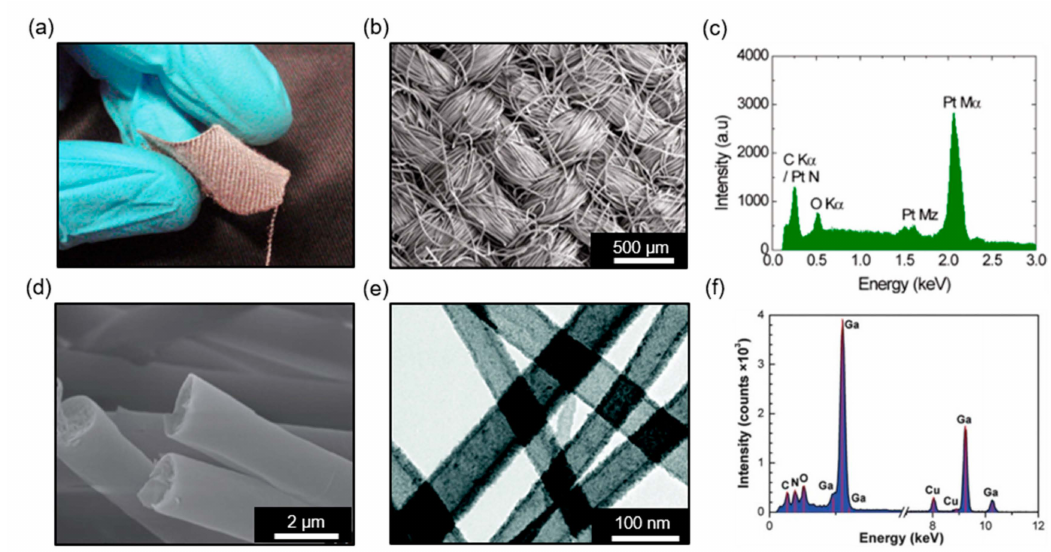
Figure 5. Various inorganic thin films conformally deposited on 3D nanonetwork polymer templates through PEALD: ( a ) digital image of a Pt thin film deposited on a woven cotton fabric; ( b ) SEM image of (a); ( c ) elemental composition of (a) (reprinted with permission from [85]. Copyright 2013 American Chemical Society); ( d ) SEM image of an AlN thin film deposited on an electrospun 3D nanonetwork (reprinted with permission from [86]. Copyright 2012 John Wiley and Sons); ( e ) TEM image of a GaN thin film deposited on an electrospun 3D nanonetwork; ( f ) elemental composition of (e) (reprinted with permission from [87]. Copyright 2015 The Royal Society of